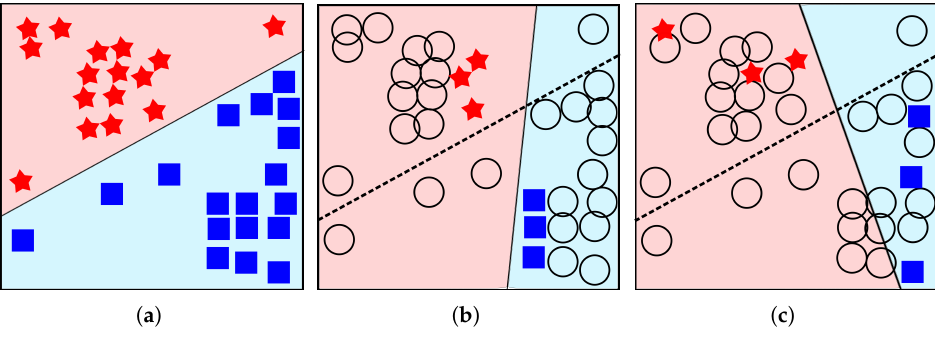
Figure 4. Visualization of the difference between information-based and representation-based query strategy. The colored points represent the labeled points, and the black circles represent unlabeled ones. The dashed lines in ( b , c ) represent the true decision boundaries. ( a ) True classification by labeling all unlabeled points. ( b ) Classification results after querying a few informative points (information-based strategy). ( c ) Classification results after querying a few representative points (representation-based